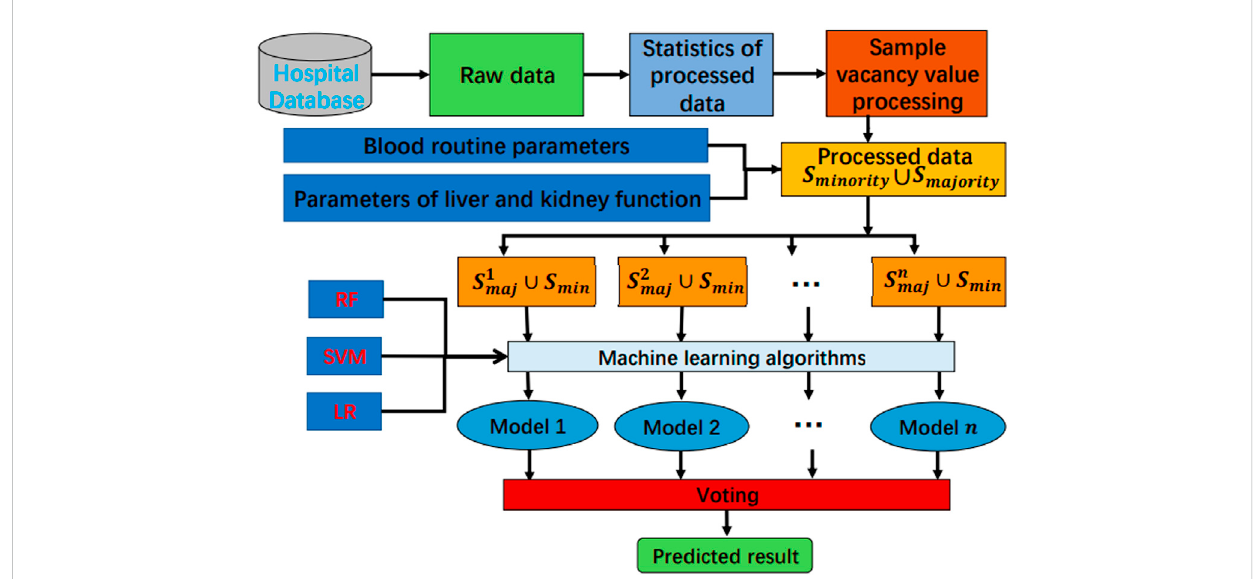
FIGURE 1 Flow chart of data analysis.